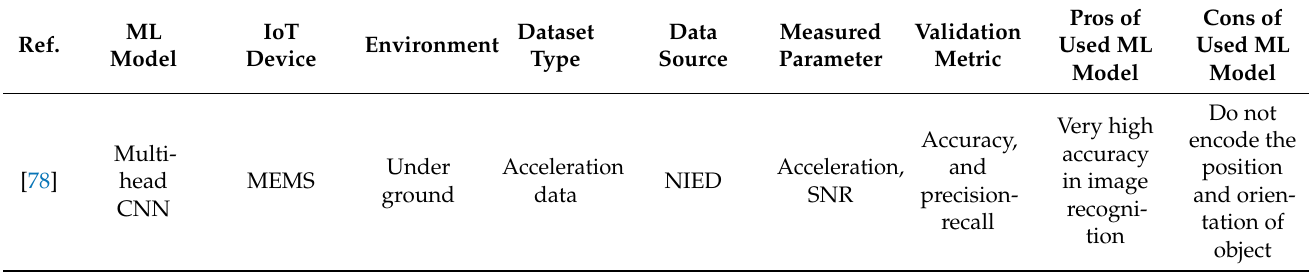
Table 3. Summary of IoT and ML main efforts for